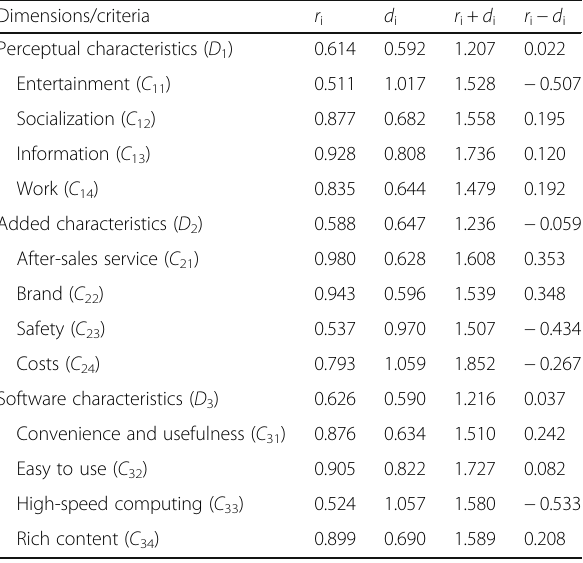
Table 3 Weighted influence of each criterion